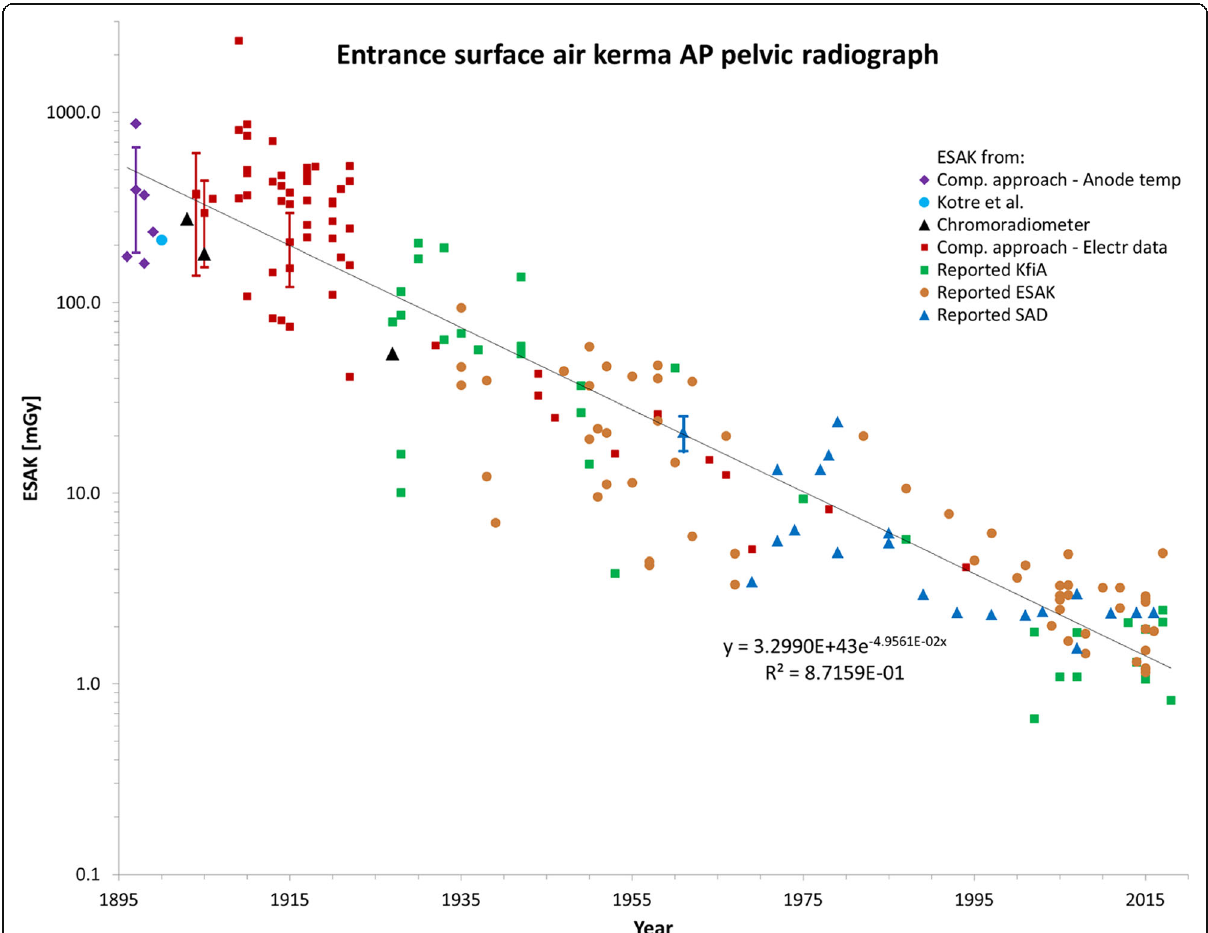
Fig. 4 Entrance surface air kerma (which includes backscatter) for pelvic radiographs 1896 – 2018 ( n = 182). “ Error bar ” in 1897 is an estimate of sensitivity to anode temperature (for a 100 °C change; see Table 6). The bars for 1904 and 1905 are from Tables 8 and 9, respectively. The 1915 bar (40% uncertainty) might be typical for 1910 – 1926. After 1927 an uncertainty in all values of about 20% seems reasonable. This is shown at 1961; the graphical size of this uncertainty bar holds at all times (1927 – 2018) due to the logarithmic scale. All references in Additional file 1: ES XV